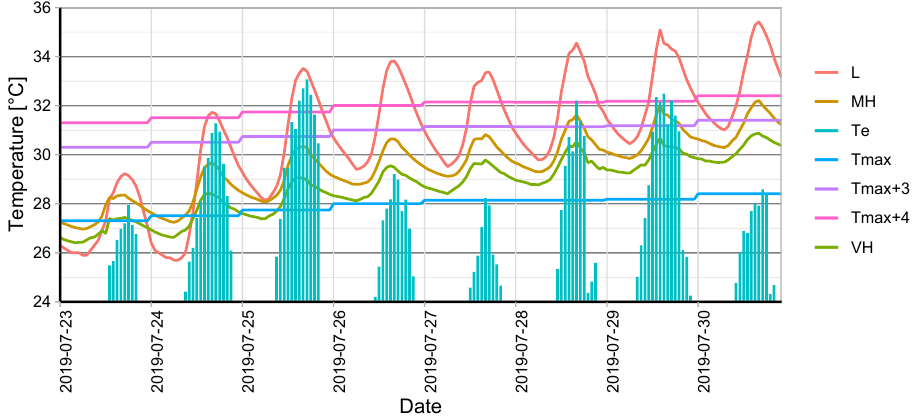
Figure 10. Daily temperature courses in individual rooms in relation to T max , T max + 3 and T max + 4 for the July heat